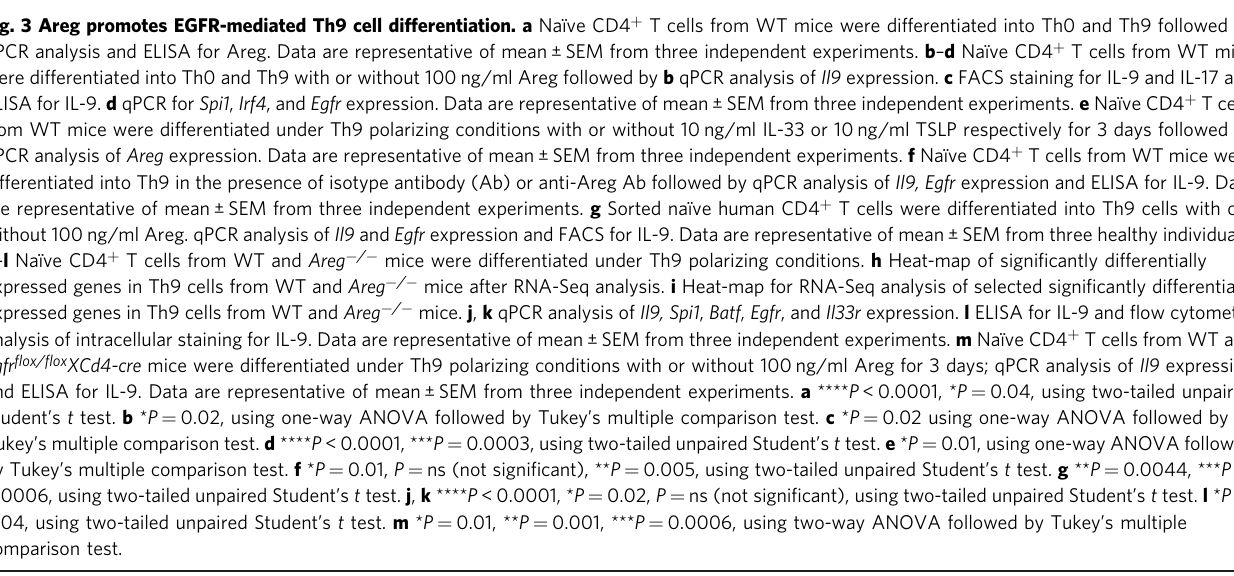
Fig. 3 Areg promotes EGFR-mediated Th9 cell differentiation. a Naïve CD4 + T cells from WT mice were differentiated into Th0 and Th9 followed by qPCR analysis and ELISA for Areg. Data are representative of mean ± SEM from three independent experiments. b – d Naïve CD4 + T cells from WT mice were differentiated into Th0 and Th9 with or without 100 ng/ml Areg followed by b qPCR analysis of Il9 expression. c FACS staining for IL-9 and IL-17 and ELISA for IL-9. d qPCR for Spi1 , Irf4 , and Egfr expression. Data are representative of mean ± SEM from three independent experiments. e Naïve CD4 + T cells from WT mice were differentiated under Th9 polarizing conditions with or without 10 ng/ml IL-33 or 10 ng/ml TSLP respectively for 3 days followed by qPCR analysis of Areg expression. Data are representative of mean ± SEM from three independent experiments. f Naïve CD4 + T cells from WT mice were differentiated into Th9 in the presence of isotype antibody (Ab) or anti-Areg Ab followed by qPCR analysis of Il9, Egfr expression and ELISA for IL-9. Data are representative of mean ± SEM from three independent experiments. g Sorted naïve human CD4 + T cells were differentiated into Th9 cells with or without 100 ng/ml Areg. qPCR analysis of Il9 and Egfr expression and FACS for IL-9. Data are representative of mean ± SEM from three healthy individuals. h – l Naïve CD4 + T cells from WT and Areg − / − mice were differentiated under Th9 polarizing conditions. h Heat-map of signi fi cantly differentially expressed genes in Th9 cells from WT and Areg − / − mice after RNA-Seq analysis. i Heat-map for RNA-Seq analysis of selected signi fi cantly differentially expressed genes in Th9 cells from WT and Areg − / − mice. j , k qPCR analysis of Il9, Spi1 , Batf , Egfr , and Il33r expression. l ELISA for IL-9 and fl ow cytometry analysis of intracellular staining for IL-9. Data are representative of mean ± SEM from three independent experiments. m Naïve CD4 + T cells from WT and Egfr fl ox/ fl ox XCd4-cre mice were differentiated under Th9 polarizing conditions with or without 100 ng/ml Areg for 3 days; qPCR analysis of Il9 expression and ELISA for IL-9. Data are representative of mean ± SEM from three independent experiments. a **** P < 0.0001, * P = 0.04, using two-tailed unpaired Student ’ s t test. b * P = 0.02, using one-way ANOVA followed by Tukey ’ s multiple comparison test. c * P = 0.02 using one-way ANOVA followed